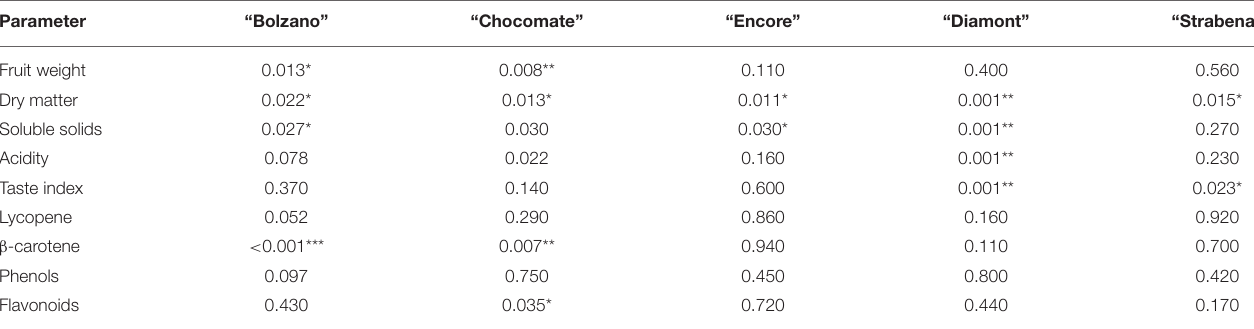
TABLE 1 | P -values (Kruskal-Wallis test) of the effects of different supplementary lightings on tomato fruit quality ( n = 118).